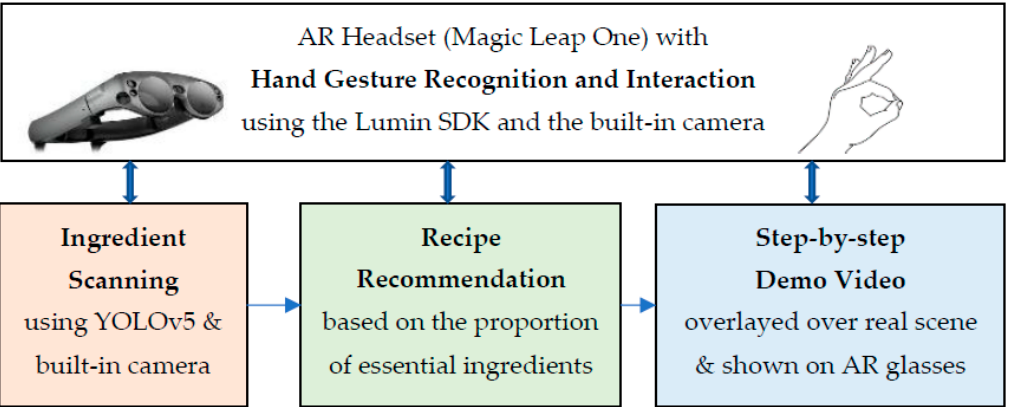
Figure 2. Three main phases of the proposed AR cooking system: food ingredient scanning, recipe recommendation, and step-by-step cooking video tutorial. The whole process can be controlled via hand gestures.